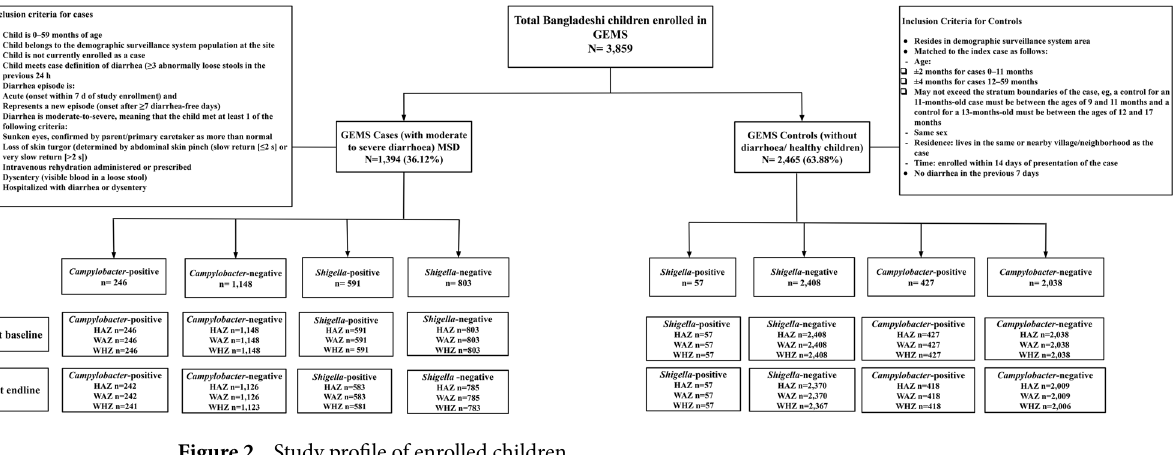
Figure 2. Study profile of enrolled